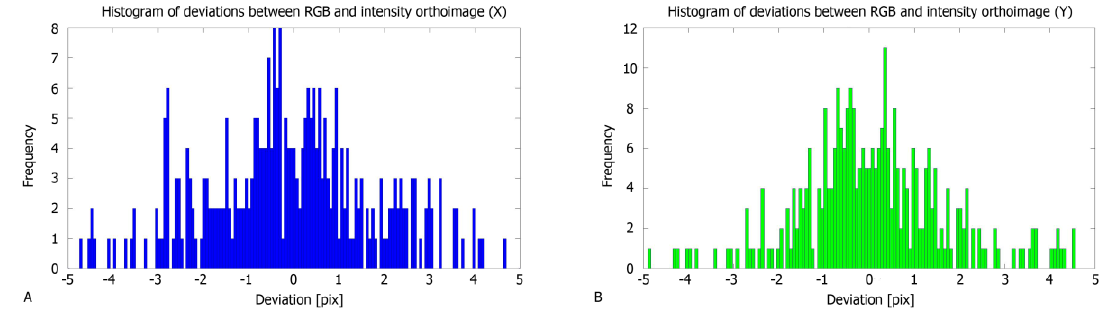
Fig. 14 Histograms of control points deviations (Image 1): A) X direction in pixels (blue), B) Y direction in pixels (green) - 3D DLT